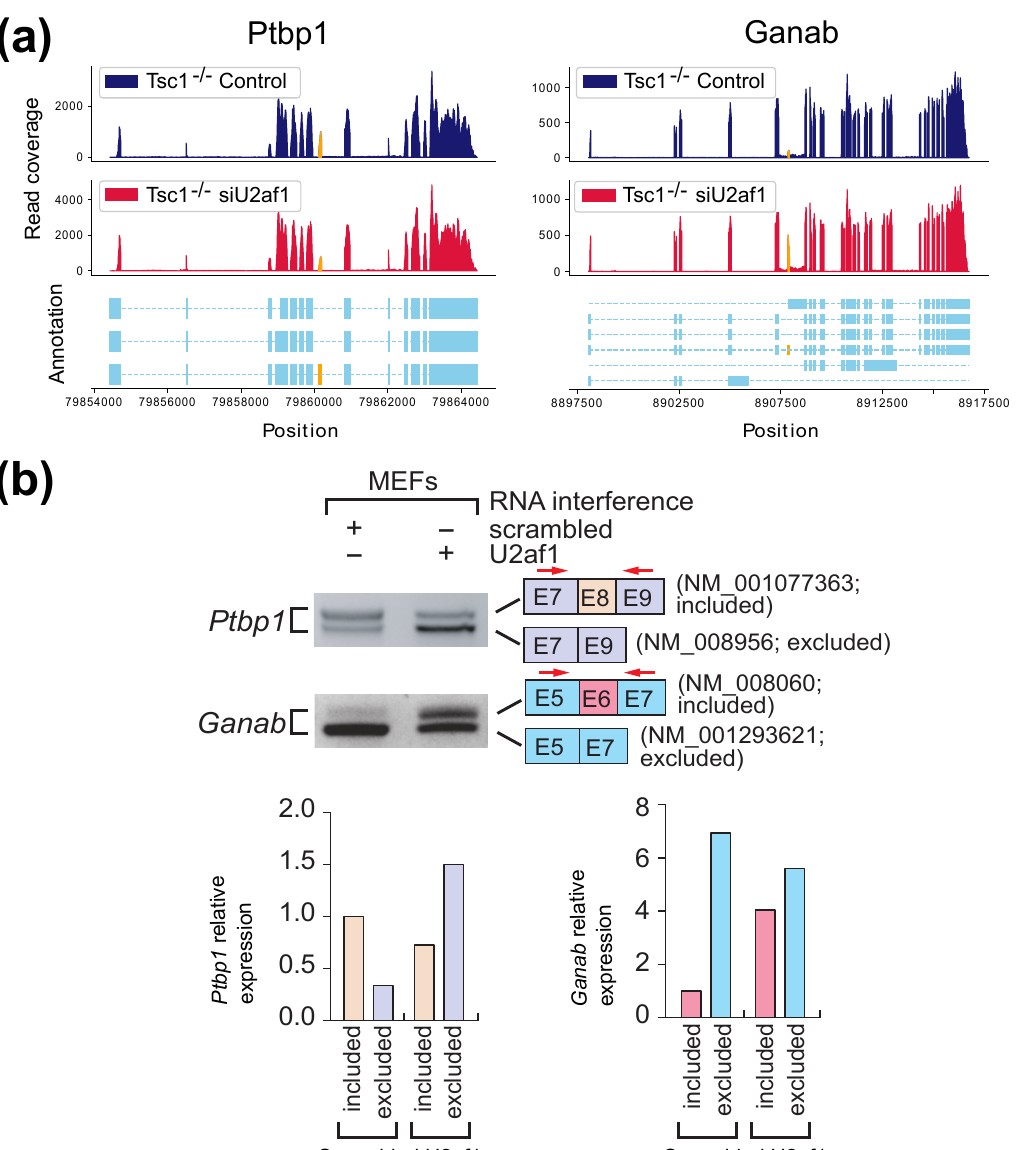
Figure 4. Validation of U2AF1-mediated alternative splicing events that are commonly detected by all four tested methods. ( a ) RNA-seq read coverage plots of the gene Ptbp1 and Ganab in the two samples with accurate isoform annotations. Alternatively spliced exons are marked in yellow. ( b ) Validation of isoform expression using RT-PCR and agarose gel electrophoresis. Quantitation of gel images was done using ImageQuant software. Exon inclusion and exclusion are color-coded. Total RNAs from Tsc 1 − / − MEFs used for RNA-Seq experiments were used for RT-PCR amplification of Ptbp1 or Ganab transcript isoforms. Scrambled RNA interference is control and U2af1 RNA interference is the case. The PCR primers to detect transcript isoforms for Ptbp1 or Ganab were marked by red arrows and their sequences are reported in the Supplementary document. Schematic of alternative spliced isoform structures for each PCR product is shown next to the gel image. Exon numbers and transcript identification numbers in RefSeq annotation are shown. A higher band intensity of PCR products indicates a higher expression of that specific transcript